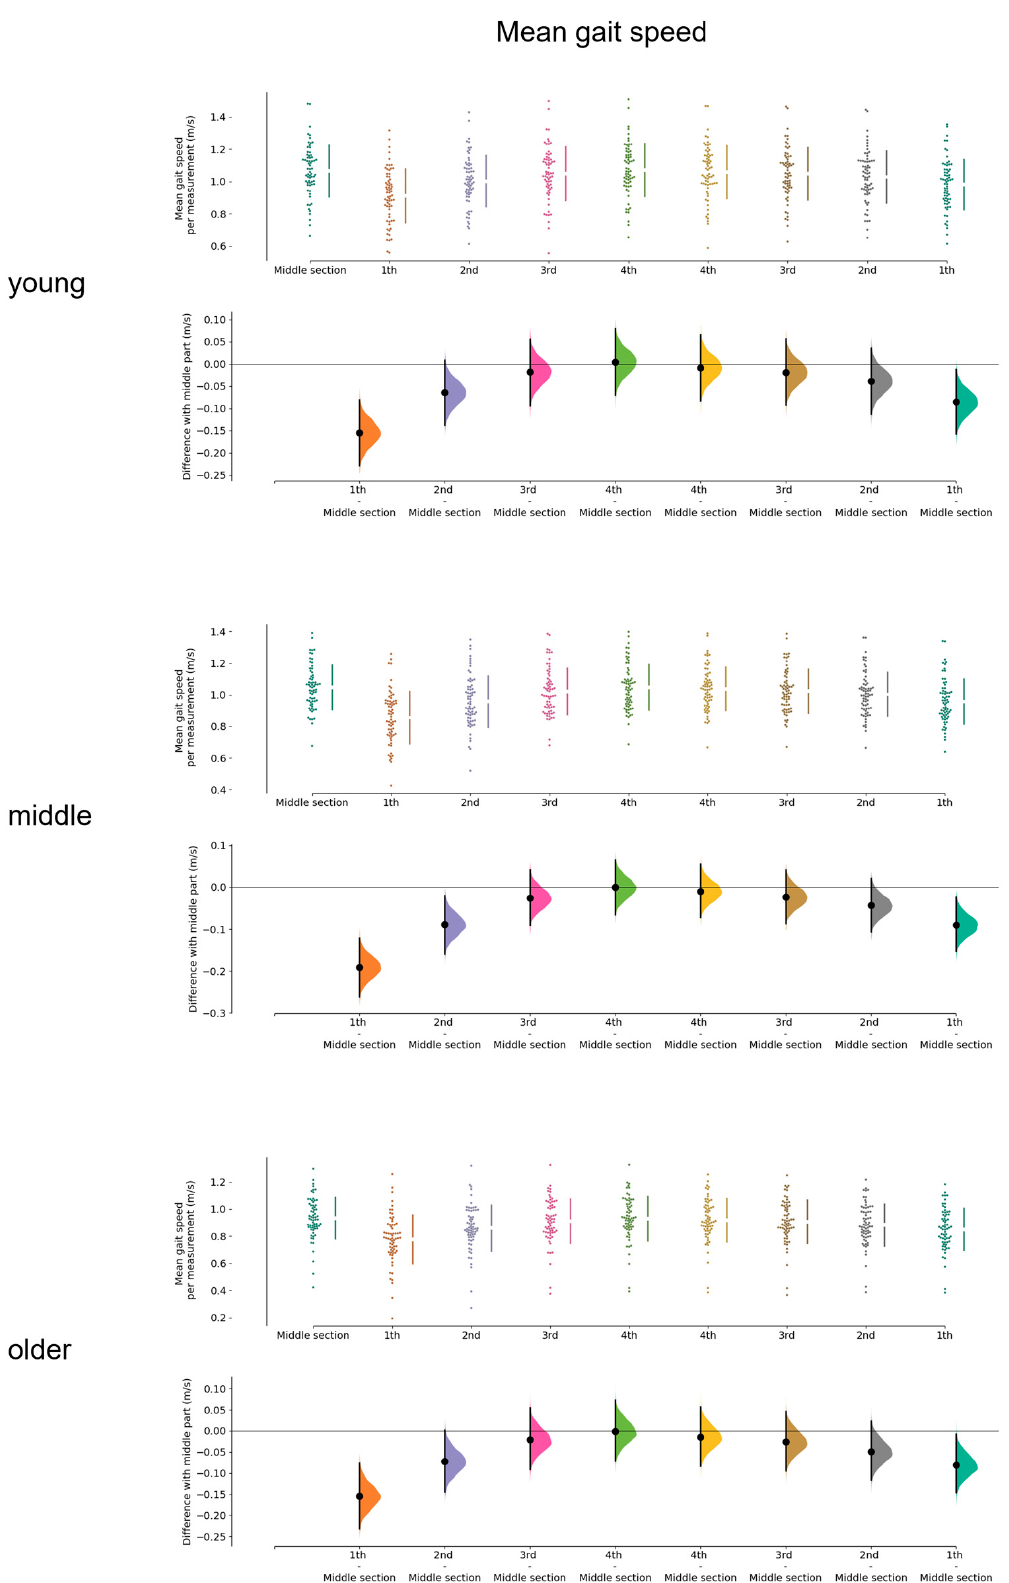
Figure A1. Mean gait speed of the different participants during the walking trajectory, and the mean differences and associated 99% CI of the first and last 4 strides around a turn. The top subplot includes data of the young age group, the middle subplot, the middle age group, and the bottom subplot, the older age group.